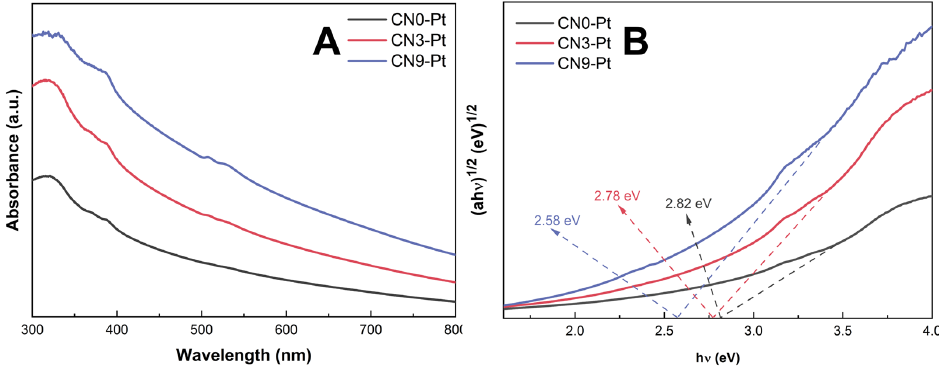
Figure 4. ( A ) UV–Vis DRS spectra and ( B ) Tauc plots for band ‐ gap energy of photocatalysts.